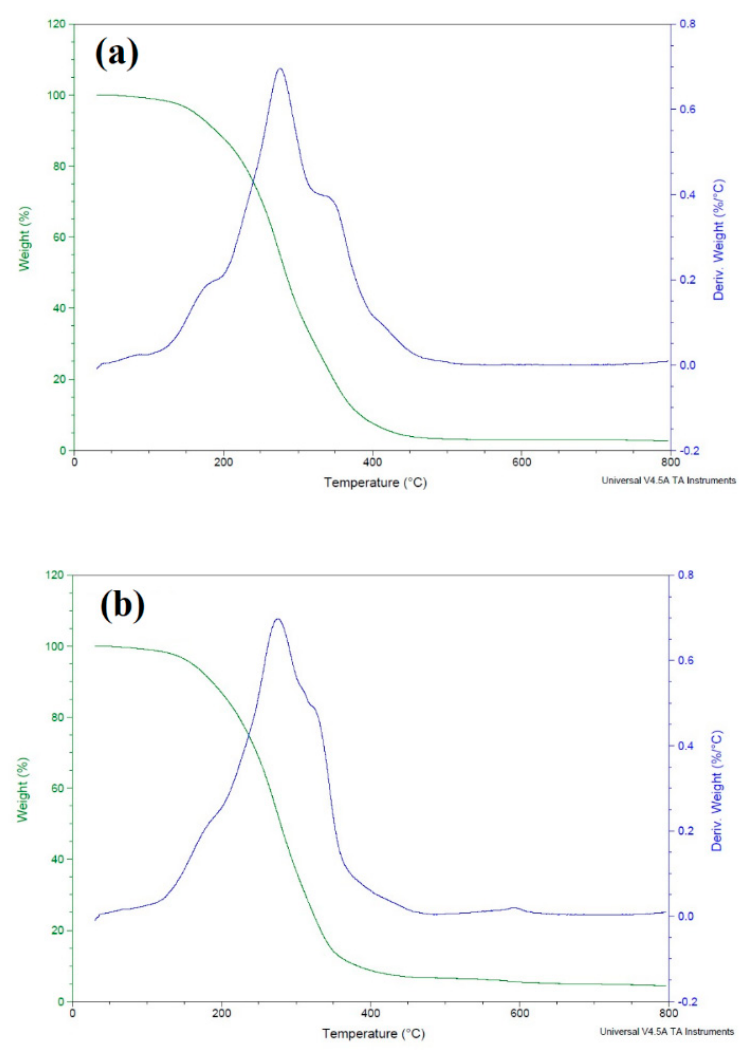
Figure 3. TGA and DTA analysis of ( a ) ATEI-IL and ( b ) ATHI-IL.